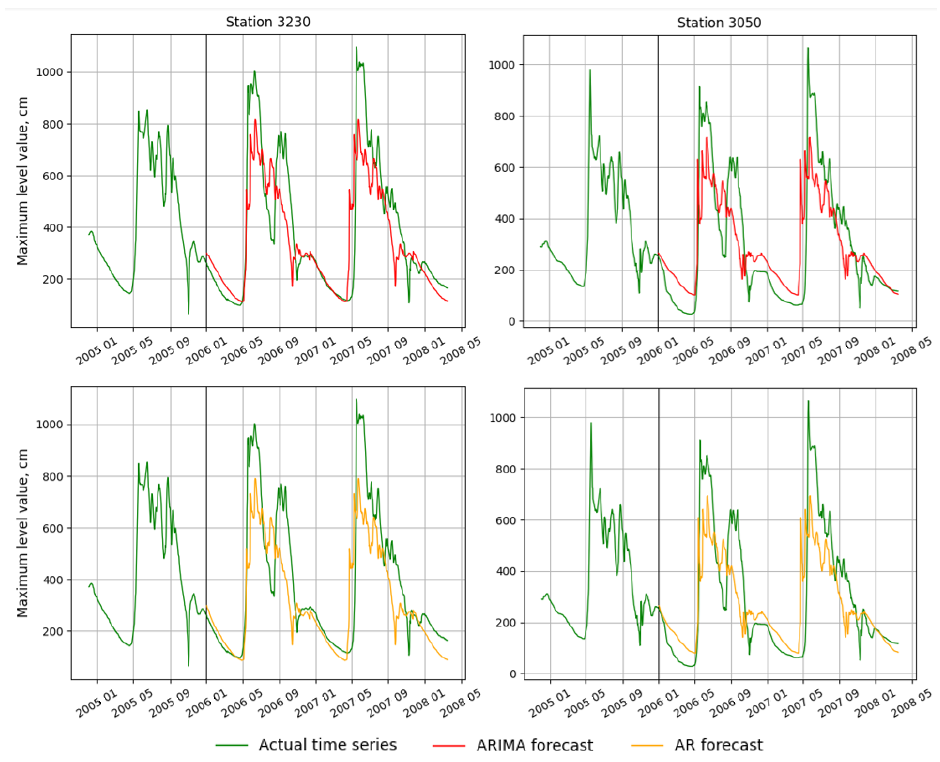
Figure 17. Forecast of statistical models (AR and ARIMA) on the validation part of water level time